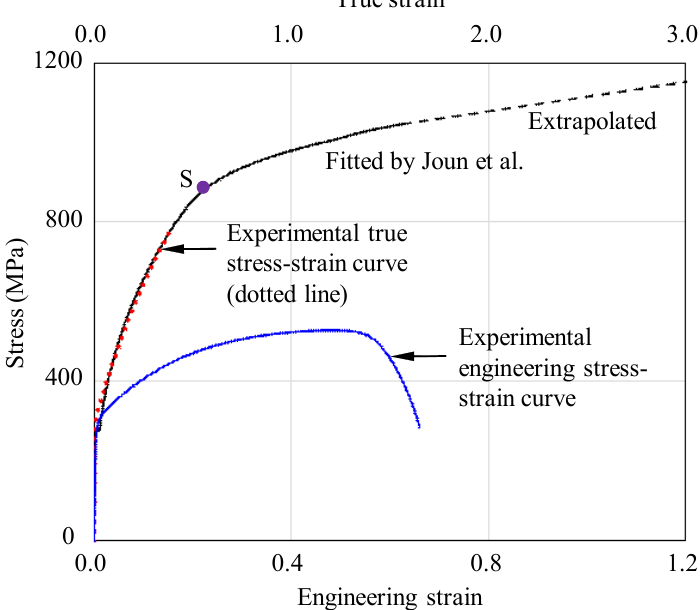
Figure 3. Tensile test curves and the flow stress curve of SUS304 at room temperature [8].